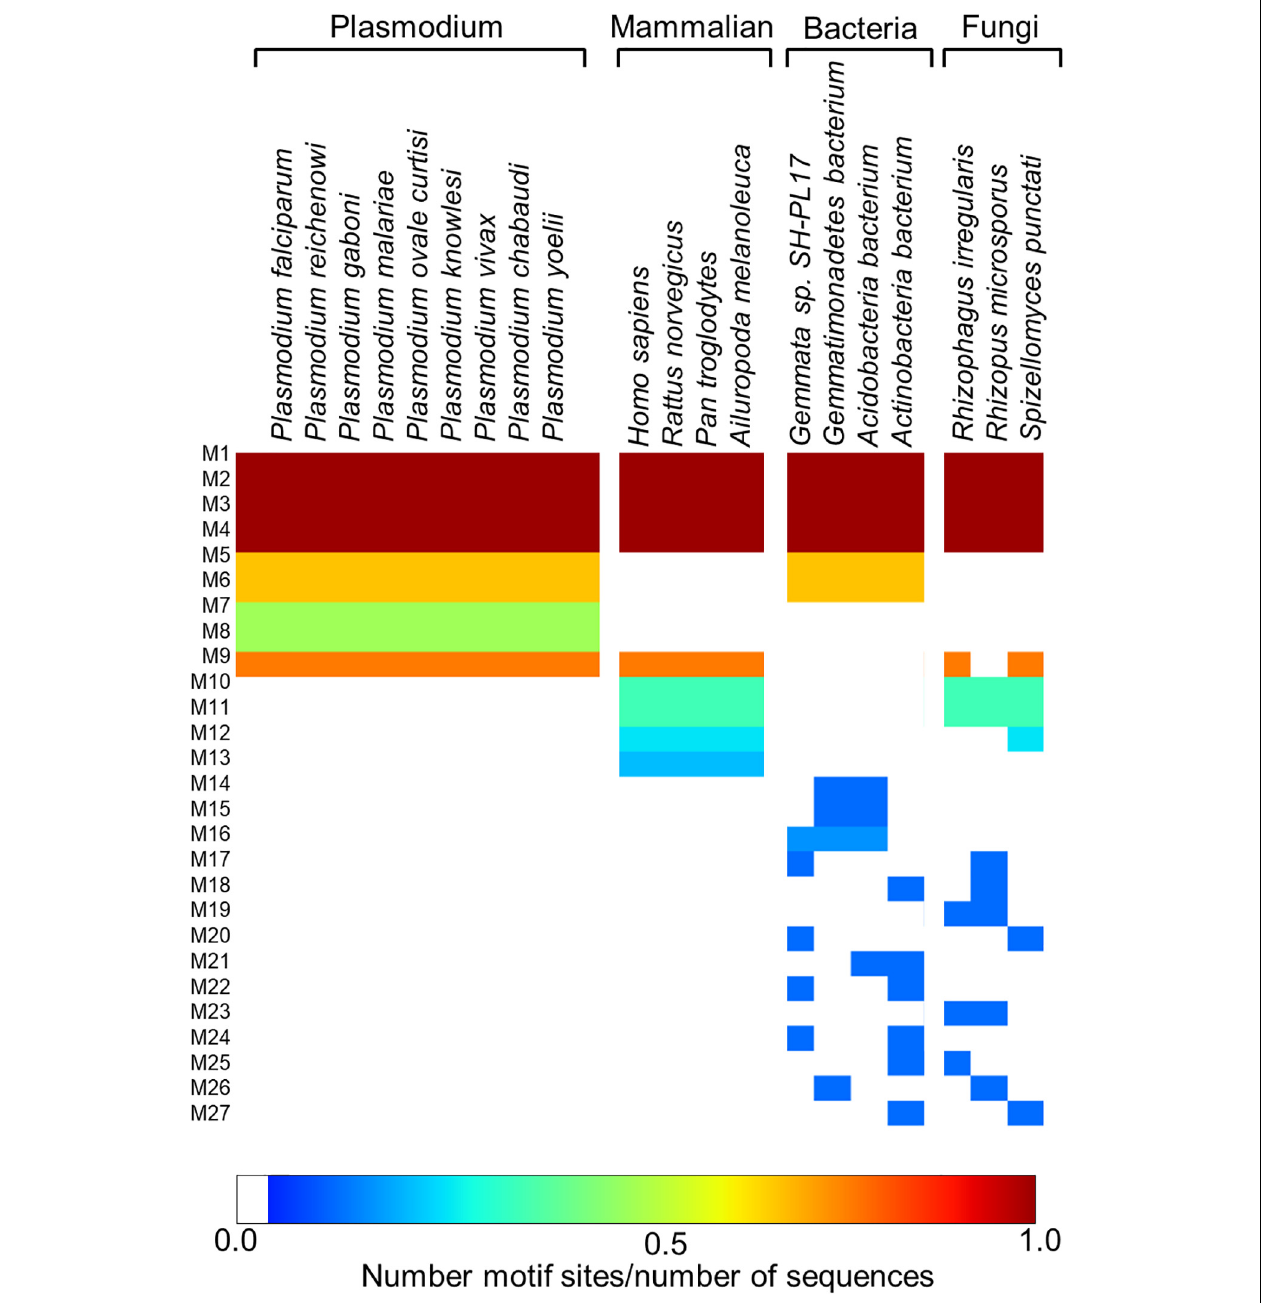
FIGURE 7 | MEME heat map summarizing motif information for groups of PTPS homologue sequences. The white regions show sequences lacking a motif and the level of conservation increases from blue to